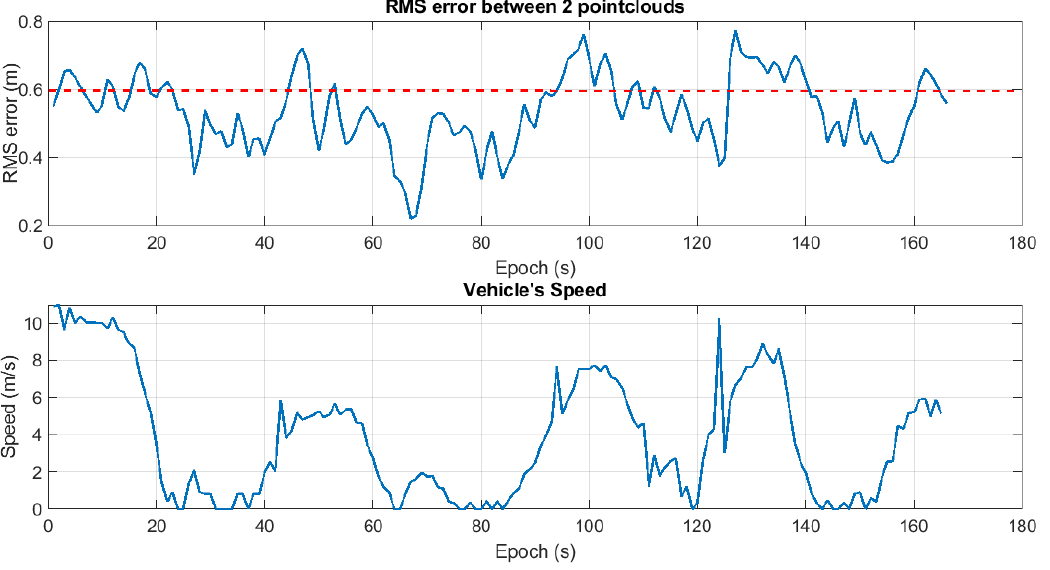
Figure 9. Root Mean Squared (RMS) error versus Speed Plot Highlighting the Average RMS error Calculated.